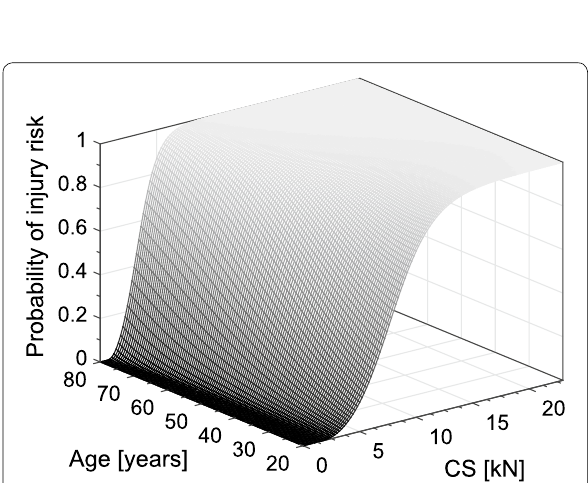
Fig. 7 Risk curve for specific ages, using Eq. 14, with R 2 = 0.9955 . CS, compressive strength